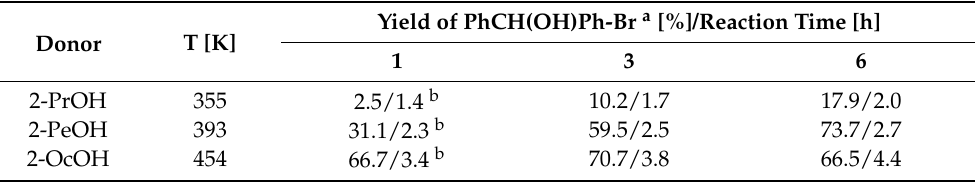
Table 2. Liquid phase transfer hydrogenation of 4-bromobenzophenone with various secondary alcohols in the presence of MgO catalyst.